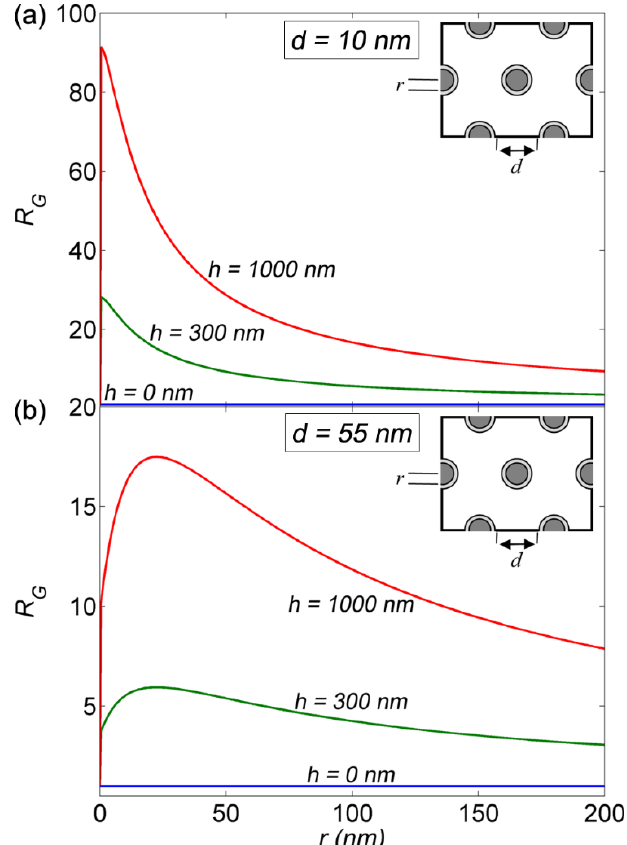
Figure 6. Evolution of the surface gain ( R G ) for hexagonally ordered ZnO nanorods as a function of the radius ( r ) and for various nanorod height ( h ). ( a ) presents the case of d = 10 nm and ( b ) presents the case of d = 55